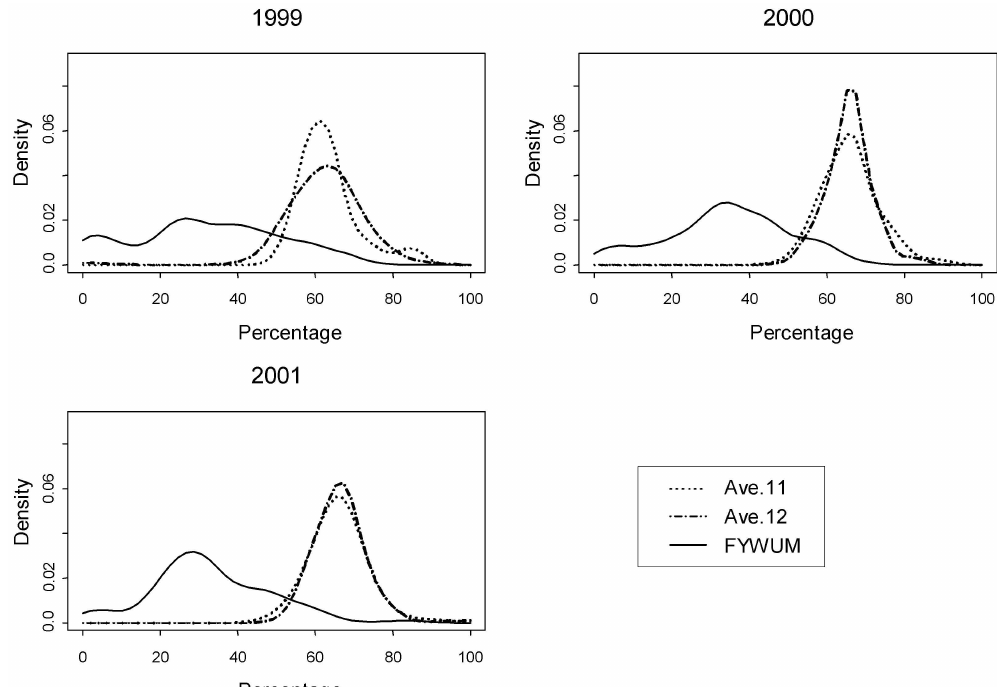
Figure 5: Kernel density estimates of the densities associated with the Grade 11 and Grade 12 mark variables and the FYWUM of the Test Battery 2 data sets for 1999, 2000 and 2001.